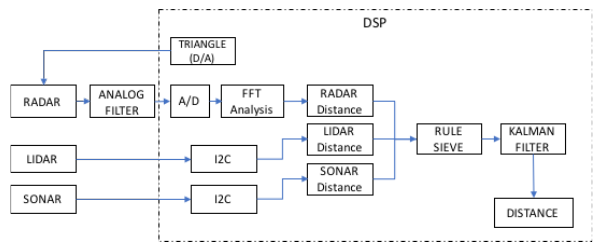
Figure 2. System